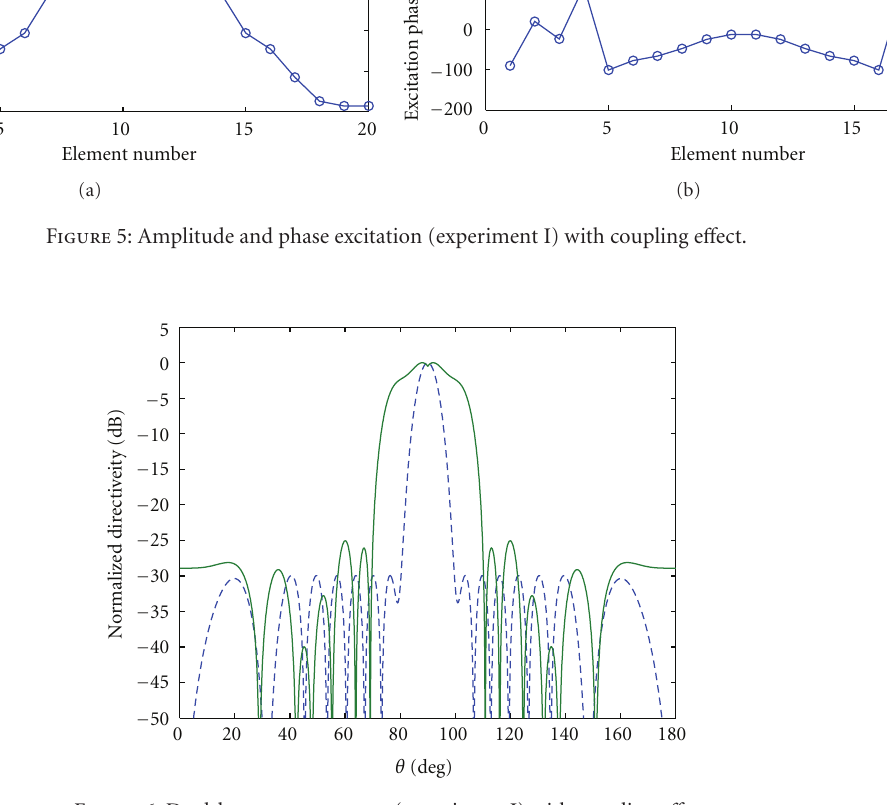
Figure 6: Dual-beam array pattern (experiment I) with coupling e ff ect